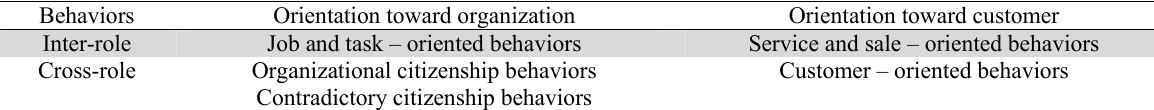
Employees’ behavior